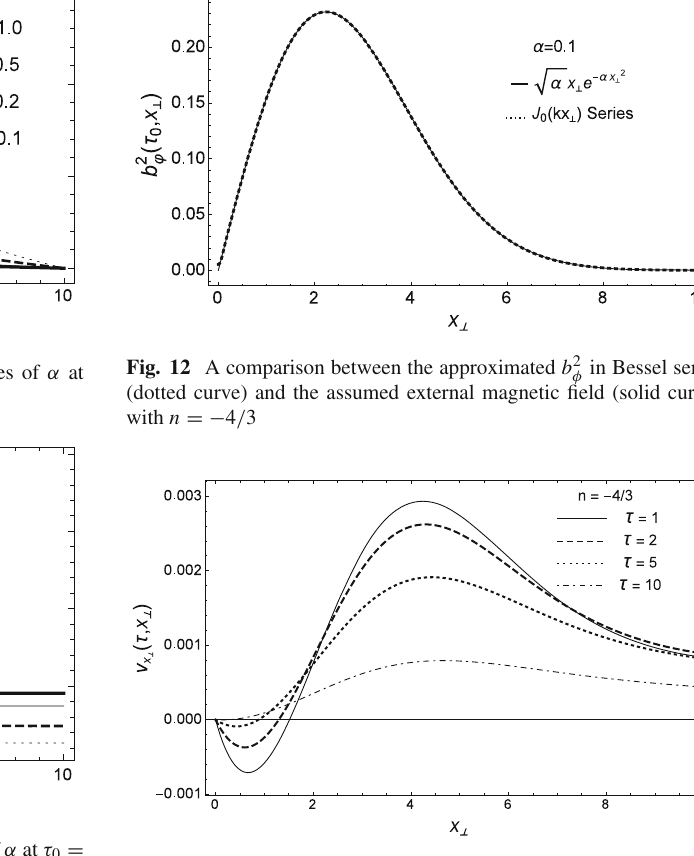
Fig. 13 v x ⊥ as a function of x ⊥ for different values of τ